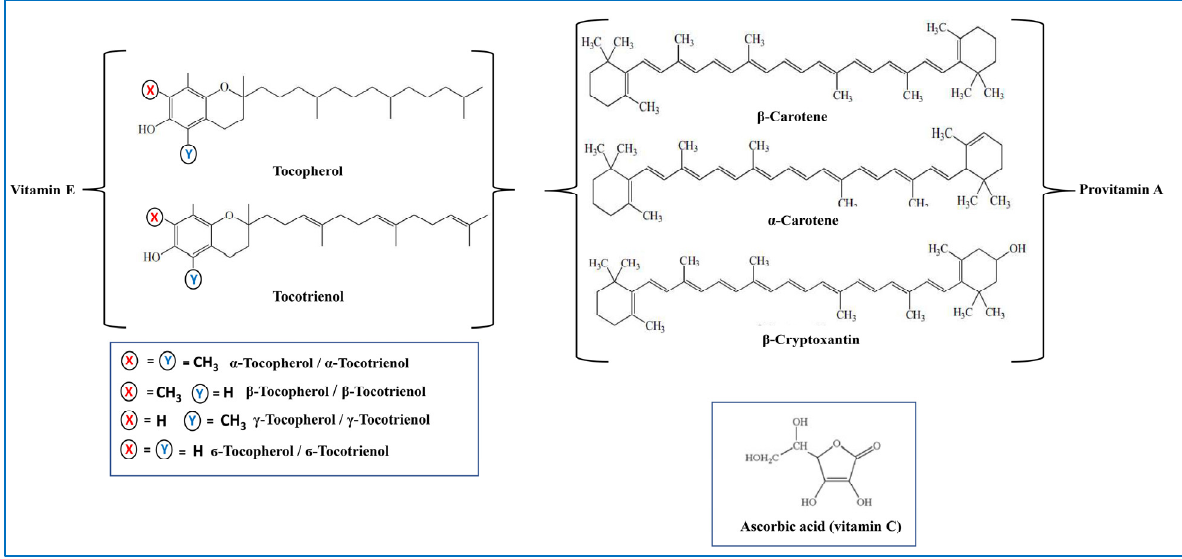
Figure 4. Chemical structure of antioxidant vitamins.